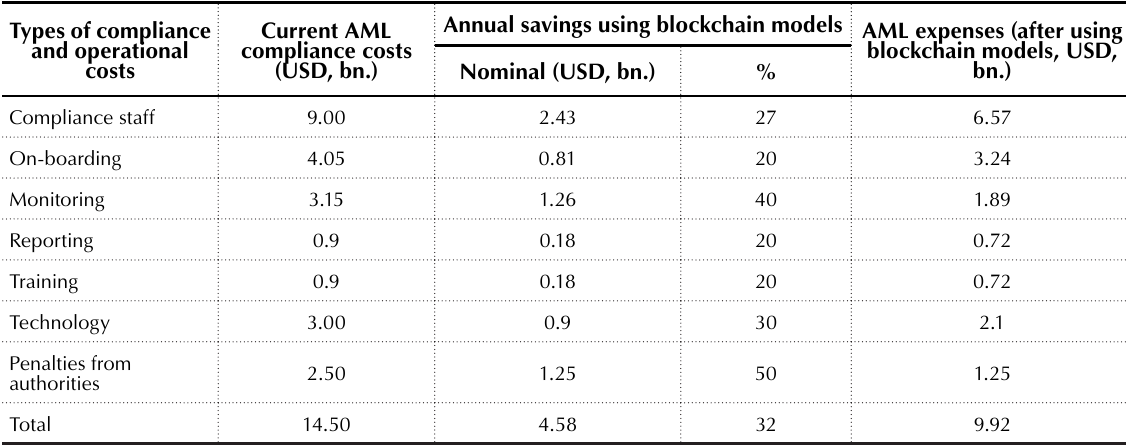
Source: Quinlan & Associates